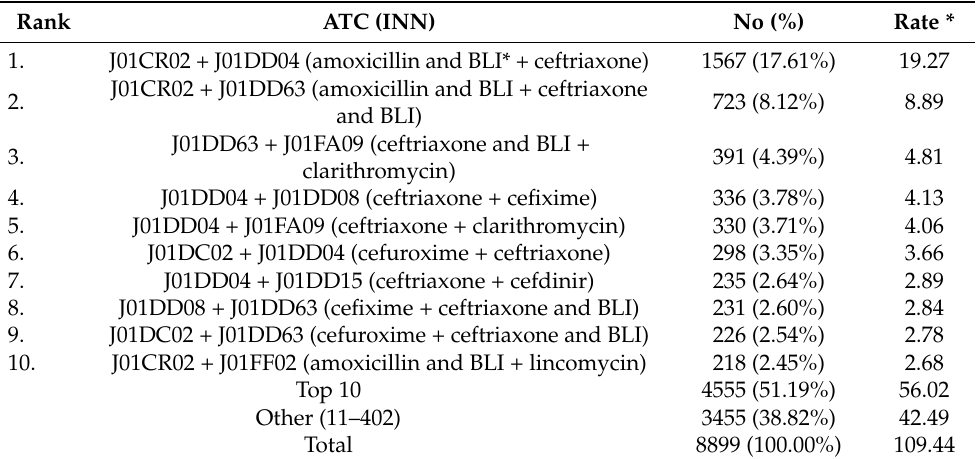
Table 4. Top ten dispensed antibiotic combinations ranked by the share of total dispensing by the individual agents (ATC5), expressed as the number of prescriptions and the number of prescriptions per 1000 persons per